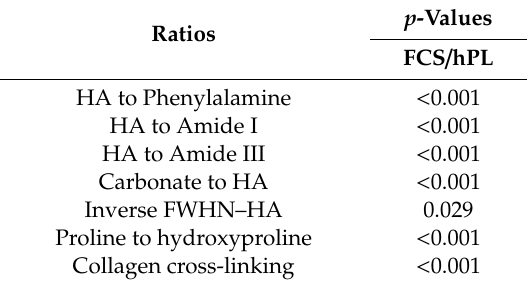
Table 1. Calculation of significant di ff erences of Raman ratios in FCS / hPL groups. p -Values Ratios FCS / hPL HA to Phenylalamine < 0.001 HA to Amide I < 0.001 HA to Amide III < 0.001 Carbonate to HA < 0.001 Inverse FWHN–HA 0.029 Proline to hydroxyproline < 0.001 Collagen cross-linking < 0.001